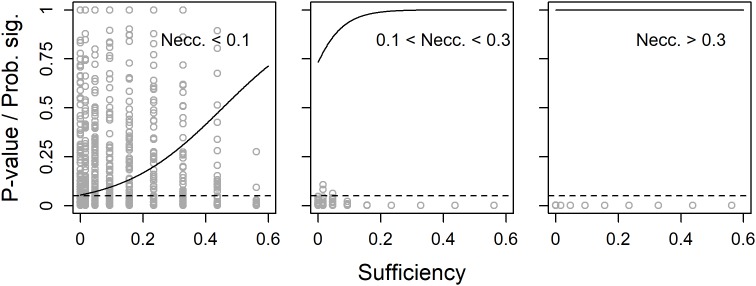
Observed p-values (dots) and predicted probability for a significant (p < 0.05) necessity effect (solid line) as functions of true population sufficiency effect, separately for three ranges of true population necessity effect. N = 45 and the dashed line shows the limit for p < 0.05.